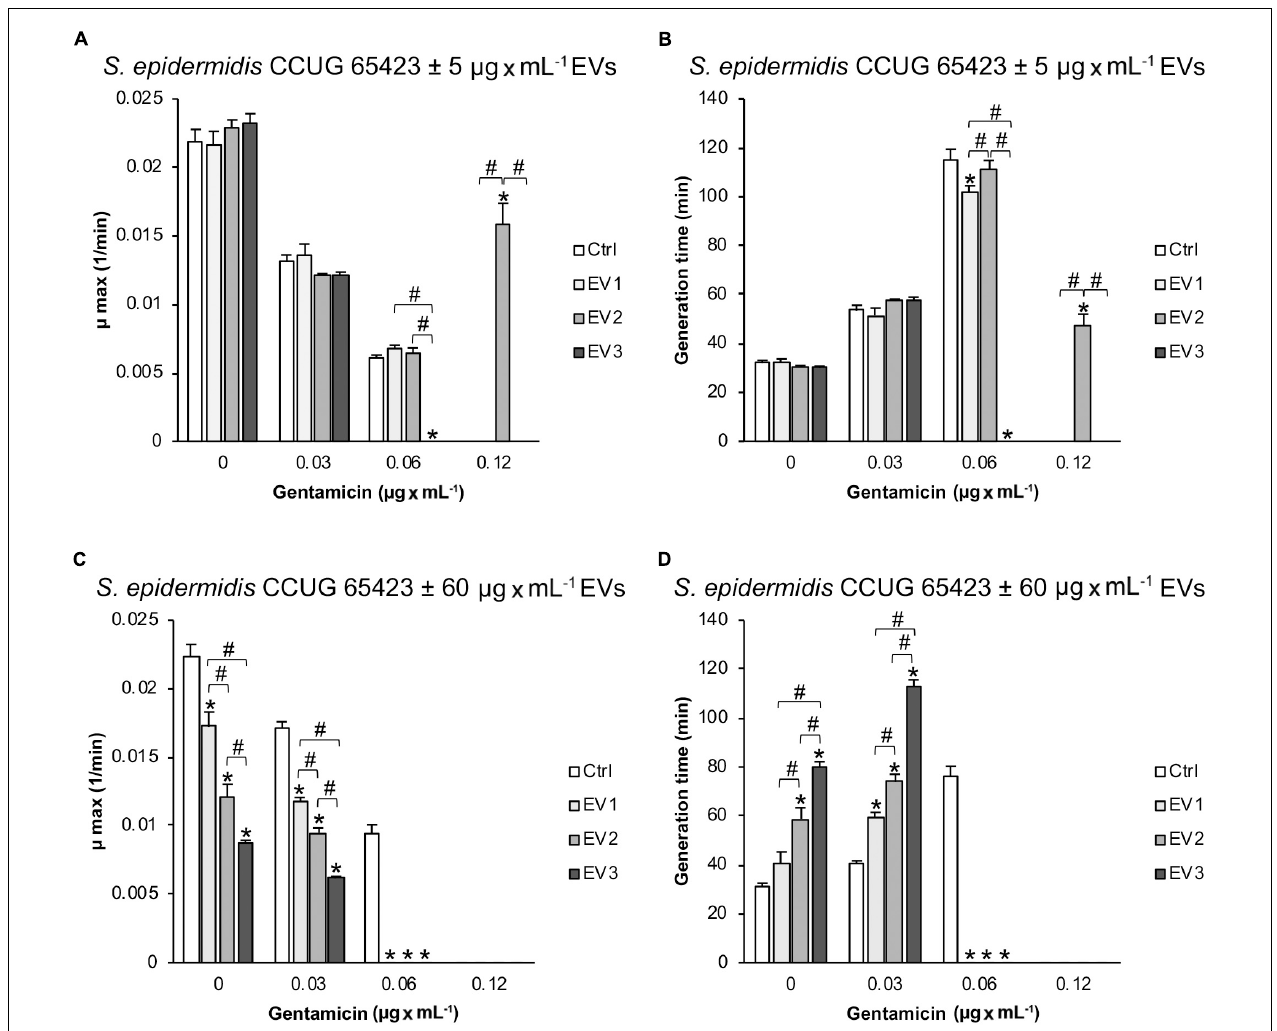
FIGURE 4 | Calculated (A–C) maximum growth rate ( µ max; min − 1 ) and (B–D) generation time (min) for the different growth curves of Staphylococcus epidermidis CCUG 64523 stimulated with (A,B) 5 µ g × mL − 1 EVs and (C,D) 60 µ g × mL − 1 EVs. The data represent the mean ± SEM ( n = 3); * indicates a significant difference compared to the Ctrl; # indicates a significant difference between different EV-stimulated groups with p <